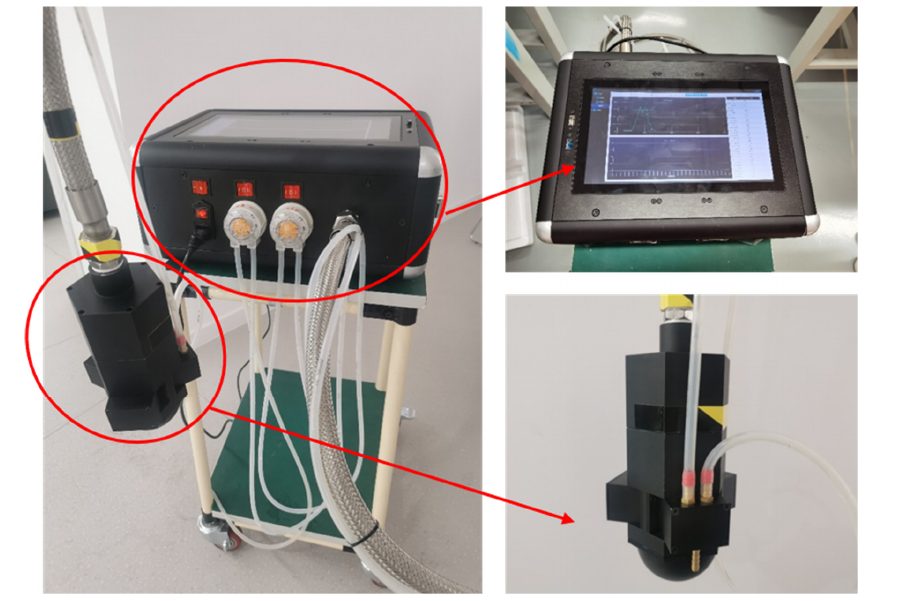
Figure 5. Lake cyanobacterial biomass spectral detection system. Figure 4. Lake cyanobacterial biomass spectral detection